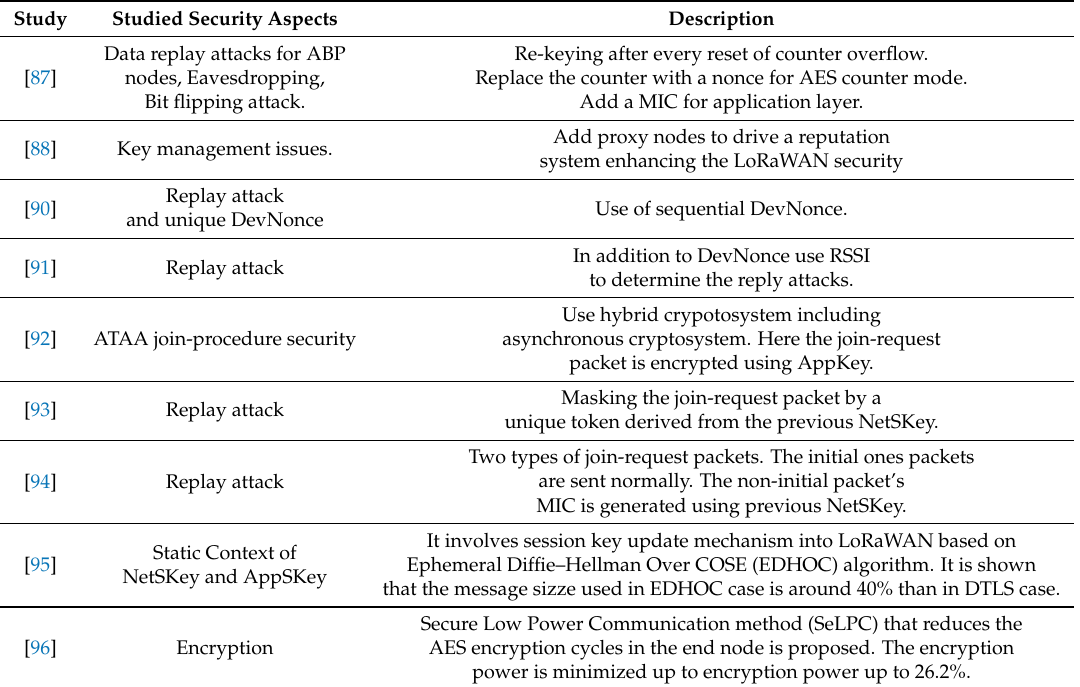
Table 7. LoRaWAN security aspects